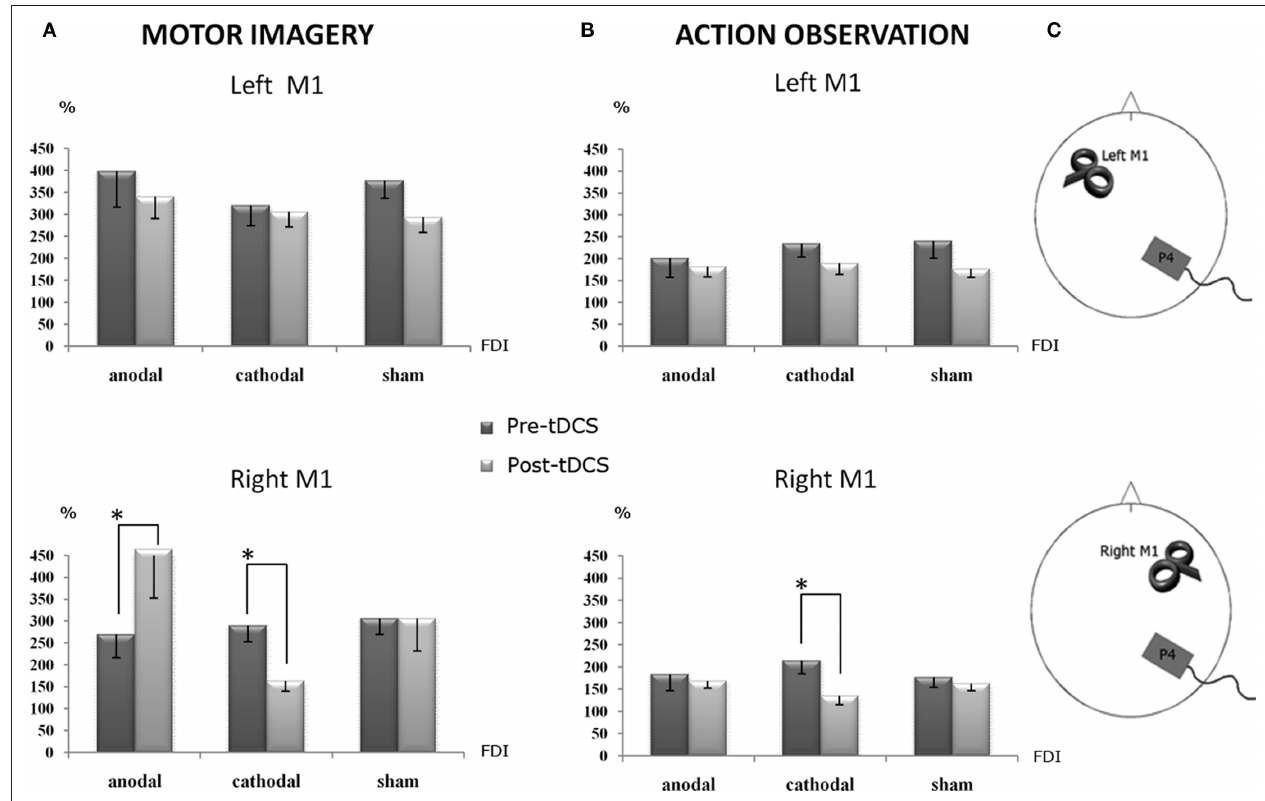
the pre-tDCS, while during the cathodal session significantly decreased it with respect to the pre-tDCS: such a double dissociation effect emerged only when TMS was applied on the right M1, ipsilateral to the conditioned parietal cortex. (B) The corticospinal facilitation induced by the action observation task, as indexed by the MEPs’ size, was still significantly decreased by cathodal tDCS with respect to the pre-tDCS condition. Again, this effect was present when the TMS was applied on the ipsilateral right M1. (C) Experimental set-up summarizing the site of tDCS conditioning and the side